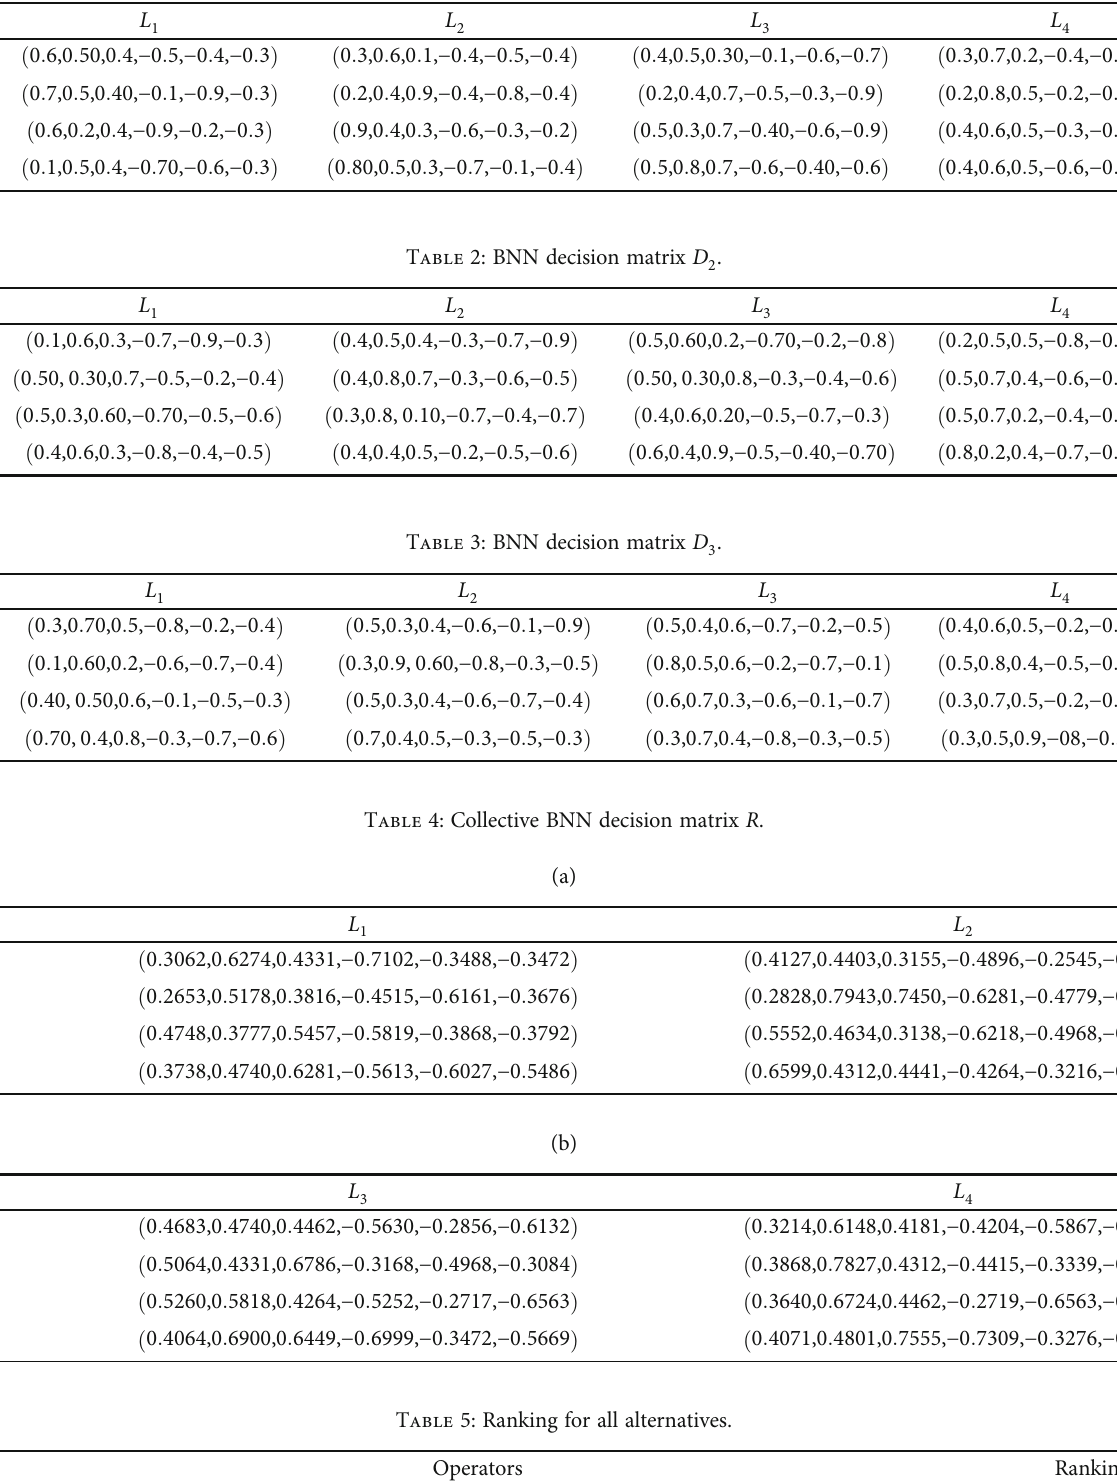
Table 1: BNN decision matrix D